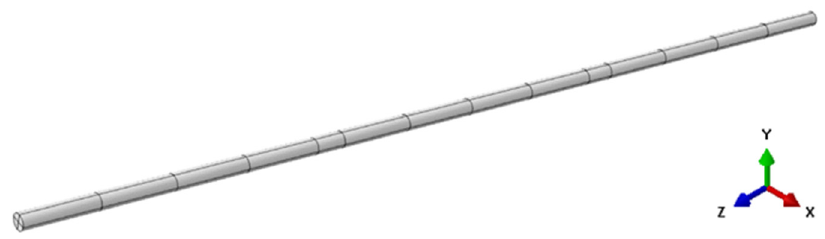
Figure 3. Geometric part—steel bolt.